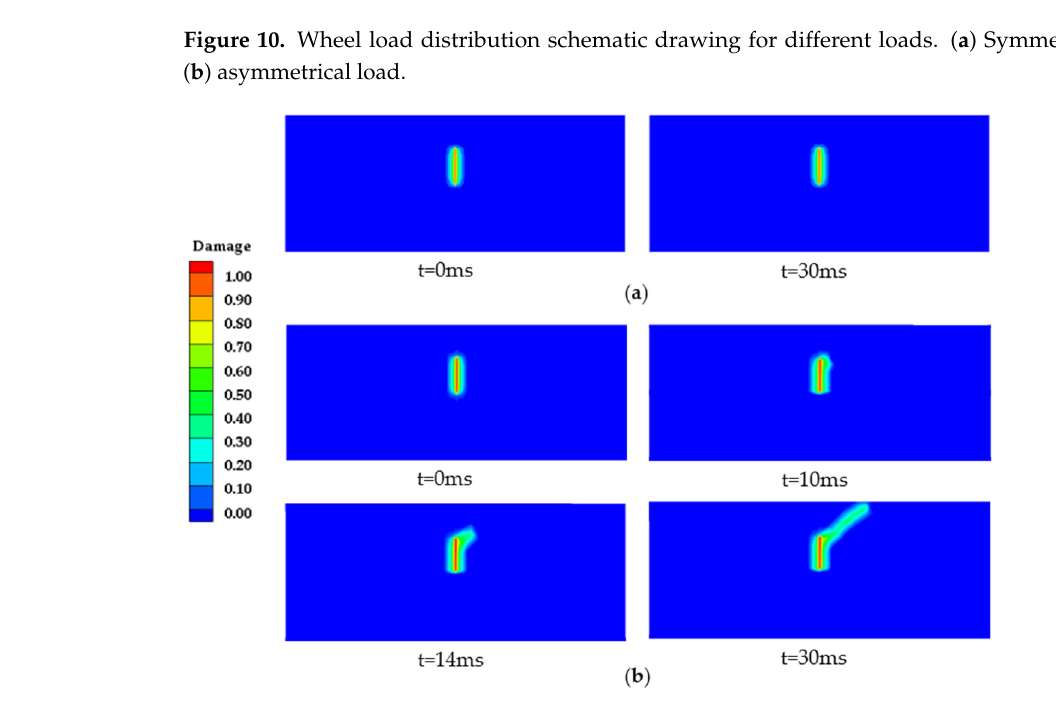
Figure 11. Crack propagation under different forms of loads. ( a ) Damage cloud image under symmetrical load; ( b ) damage cloud image under asymmetrical load.